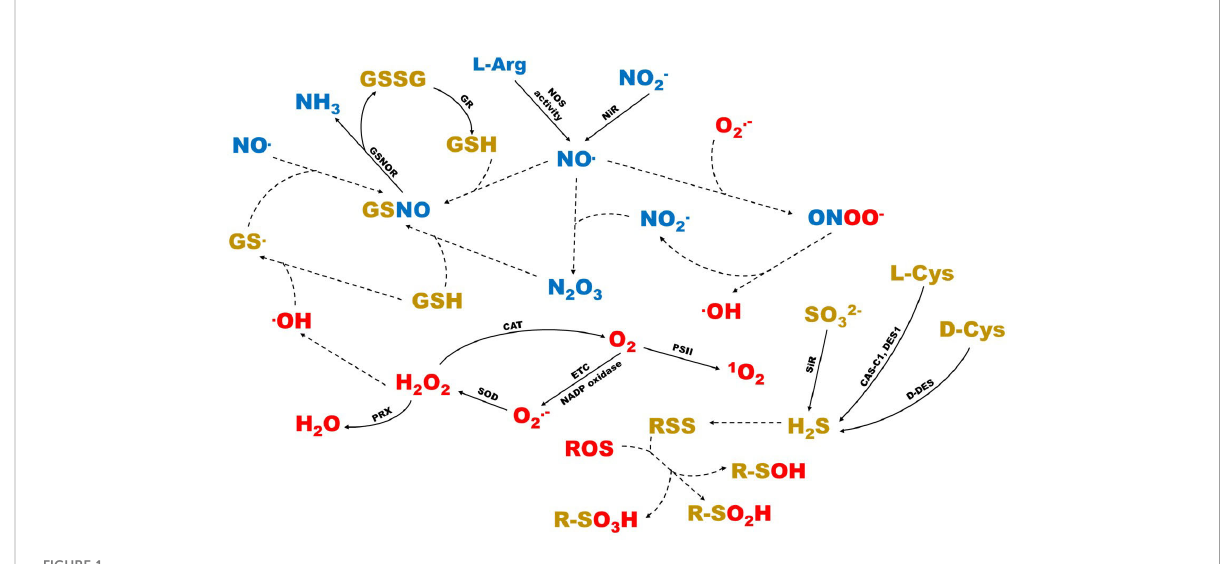
FIGURE 1 Schematic representation of the interactions between the different ROS, RNS and RSS in the plant cell. In red, the different types of ROS are shown. In blue, the different types of RNS are shown. In gold color, the different types of RSS are shown. Dashed arrows represent reactions that take place non-enzymatically. CAS-C1, cyanoalanine synthase c1; CAT, catalase; D-DES, D-cysteine desulfhydrase; DES1, L-cysteine desulfhydrase 1; ETC, electronic transport chains; GR, glutathione reductase; GSNOR, S-nitrosoglutathione reductase; NiR, nitrite reductase; PRX, peroxidase; PSII, photosystem II; SiR, sul fi te reductase; SOD, superoxide